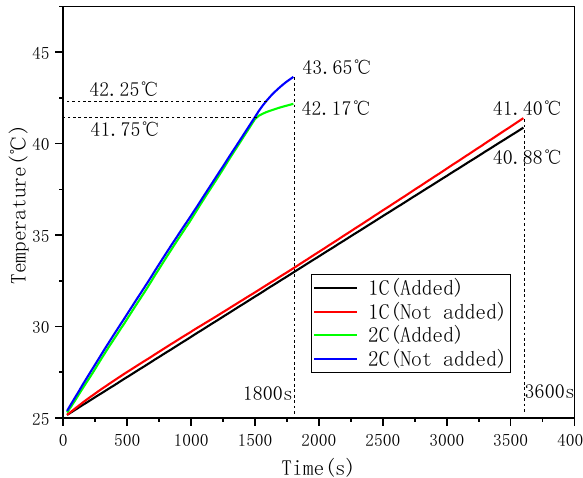
Figure 14. Temperature response curves of battery modules with and without TSG under 1C and 2C discharge conditions.